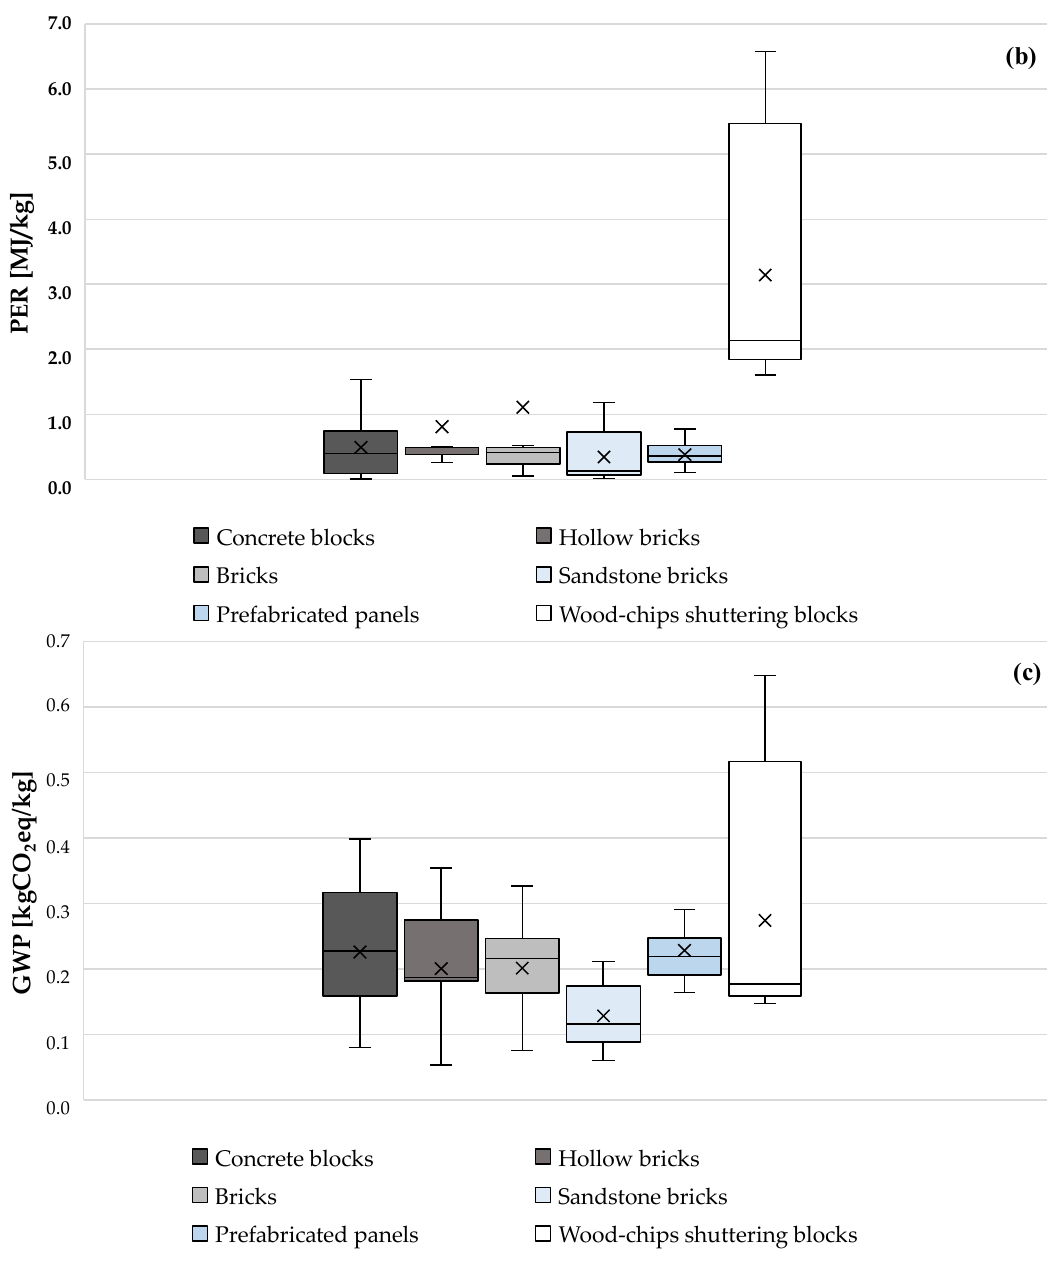
Figure 6. Embodied impacts of different products: ( a ) PENR, ( b ) PER, ( c ) GWP. Whiskers: maximum and minimum value; box: median of 1st, 2nd and 3rd quartile; ×: mean of the sample.